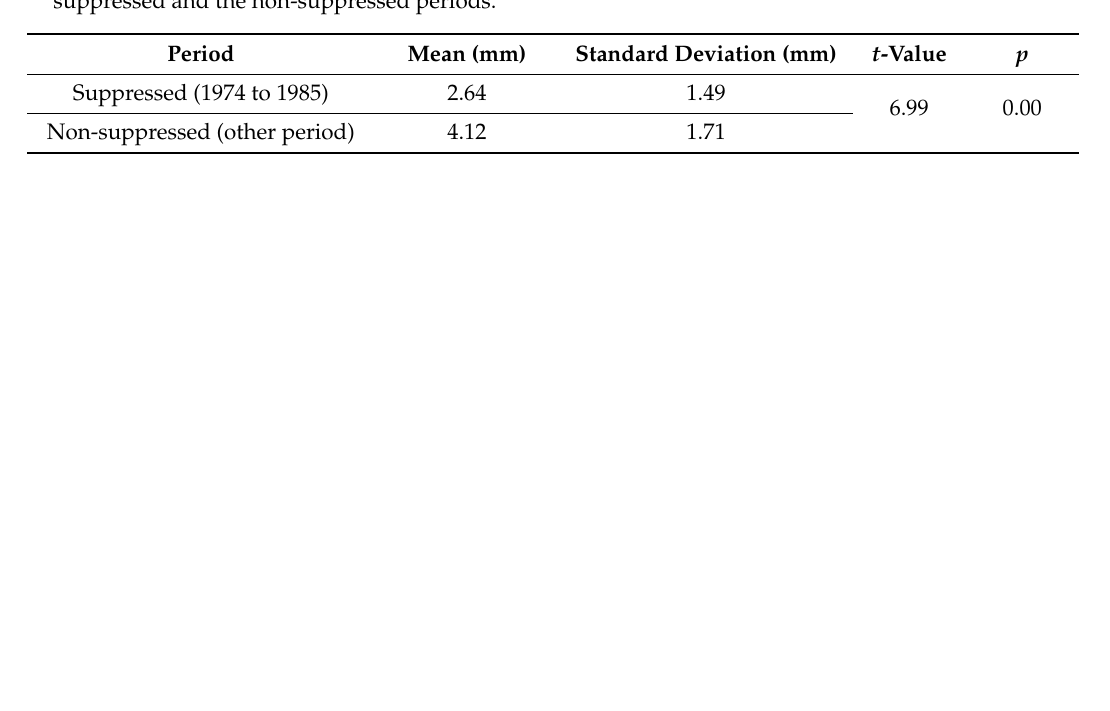
Table 1. The result of t -test for the di ff erence in annual ring growth of P. densiflora between the suppressed and the non-suppressed